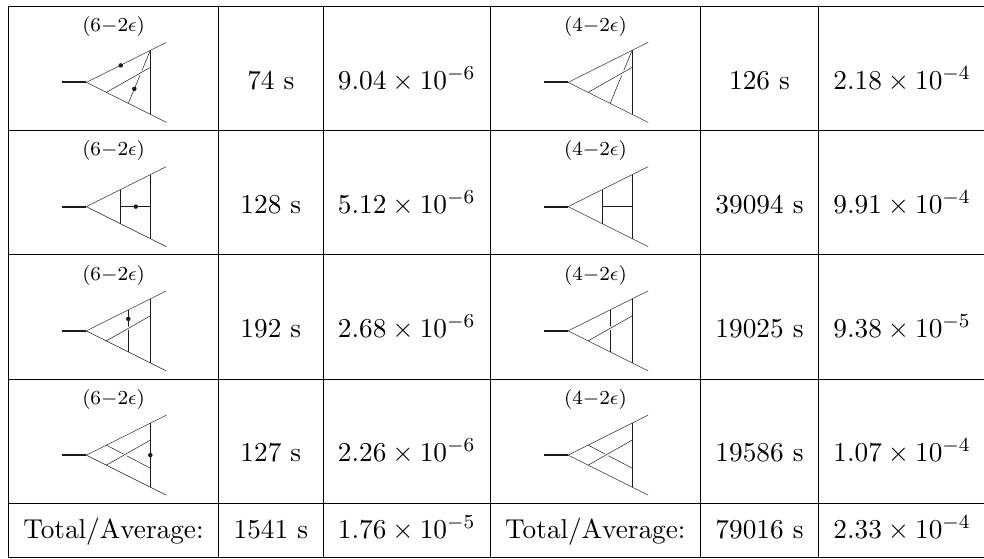
Table 3. Numerical performance of (cid:12)nite and conventional integral bases for massless three-loop form factors with FIESTA 4 . In addition to the run times, the fractional di(cid:11)erence from the exact value is shown. In the (cid:12)nal row of the table, total run times and average relative accuracies are